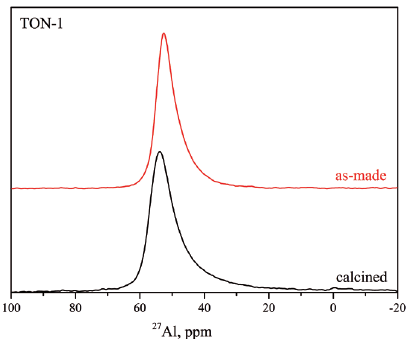
Figure 4: 27 Al NMR of as-made and calcined TON-1 sample obtained with ionic liquid by method A. calcination (TON-1 sample – obtained in 3 days in stirring – Figure 4), in a Si/Al molar ratio of 50 (gel). The final